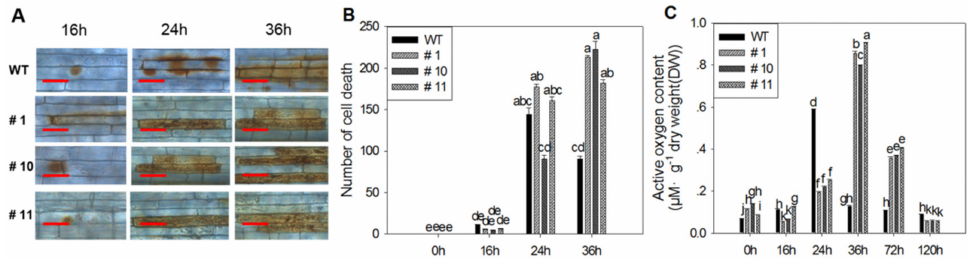
Figure 4. Cell death and ROS accumulation in plant leaves during rice–blast pathogen interaction. ( A ) DAB staining in leaf sheath cells. Bars = 25 µ m. ( B , C ) The number of dead cells ( B ) and active oxygen content ( C ) in plant leaves during rice-blast pathogen interaction. Di ff erent letters represent statistically significant di ff erences ( p <